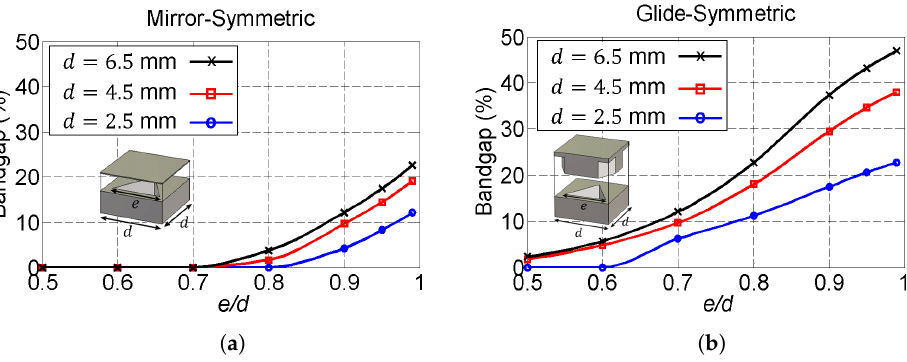
Figure 11. Relative bandgap in the ( a ) mirror-symmetric and ( b ) glide-symmetric structures with equilateral triangular holes as a function of the period d and the triangle side e . The geometrical parameters of the considered unit cells are: h hole = 1.5mm, and g = 0.2mm.